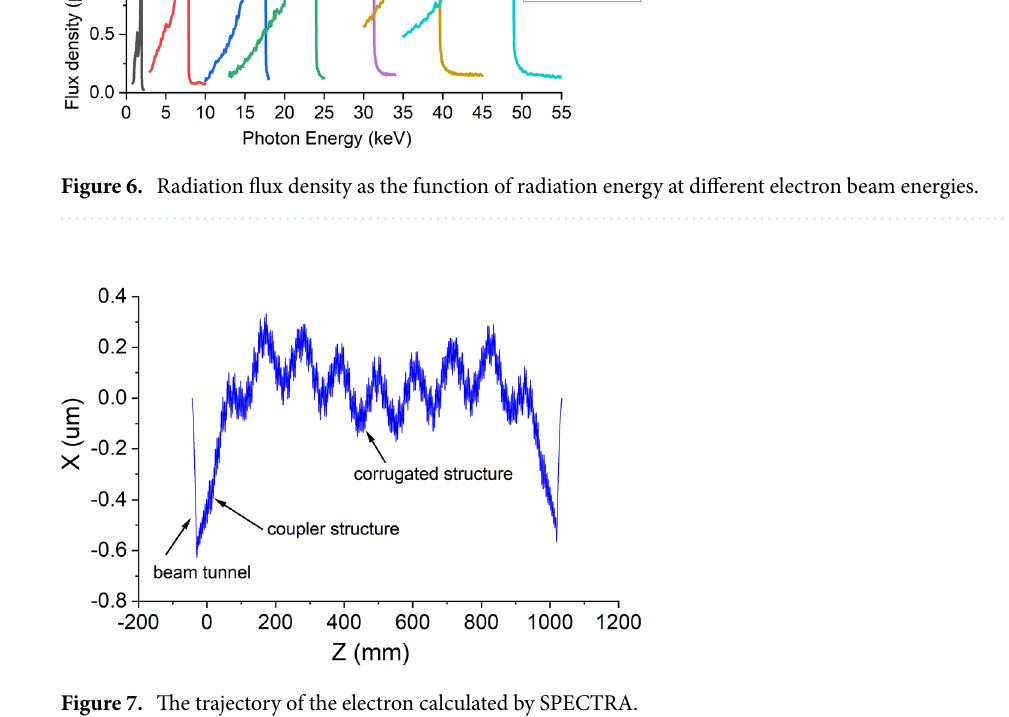
Figure 7. The trajectory of the electron calculated by